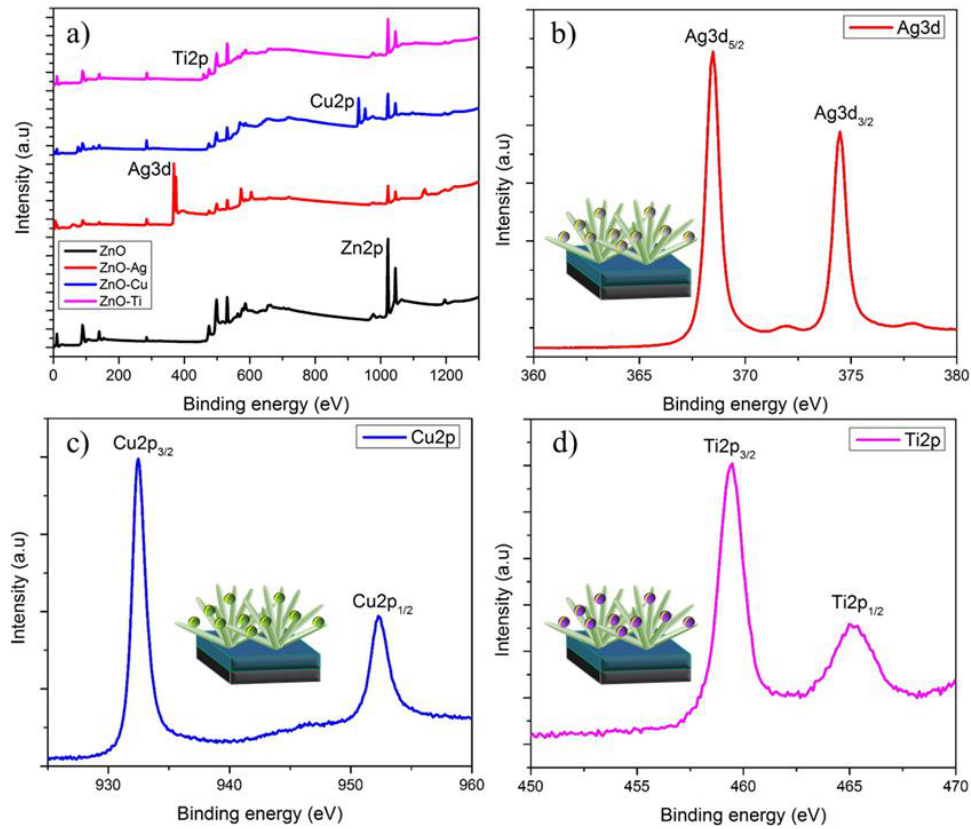
Figure 2. ( a ) XPS survey spectra of ZnO NFs deposited with Ag, Cu, and Ti; ( b ) Ag XPS scan image; ( c ) Cu XPS scan image; ( d ) Ti XPS scan image. ( c ) Cu XPS scan image; ( d ) Ti XPS scan